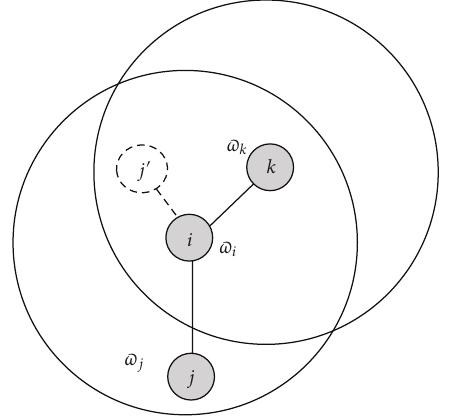
Figure 1: The case where node (cid:2) j has wrong estimated location.